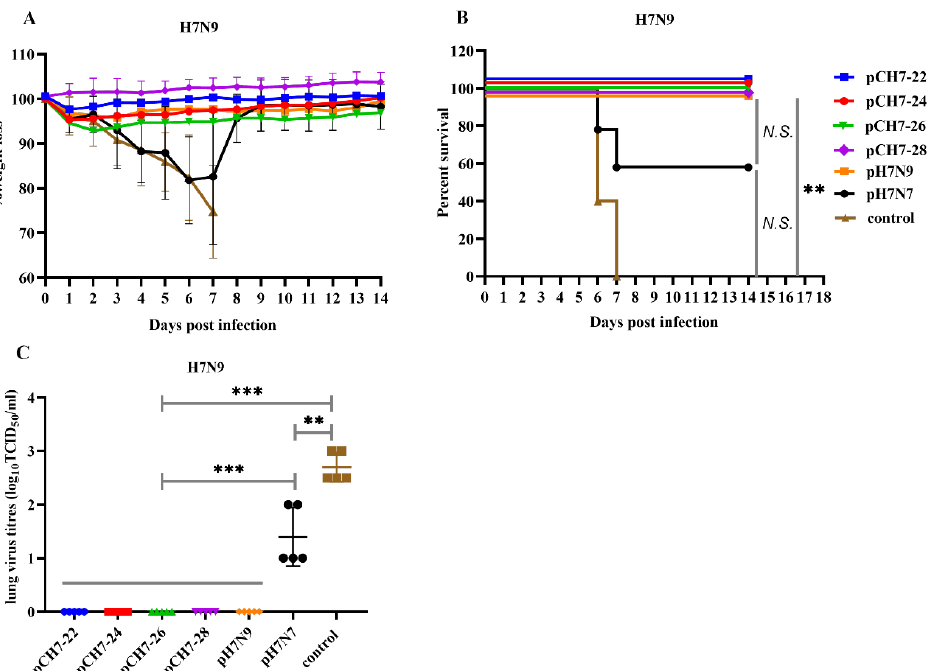
Figure 7. DNA vaccination with consensuses H7 confers protection against lethal H7N9 influenza virus challenge in mice. Groups of mice were vaccinated twice with pCH7-22, pCH7-24,